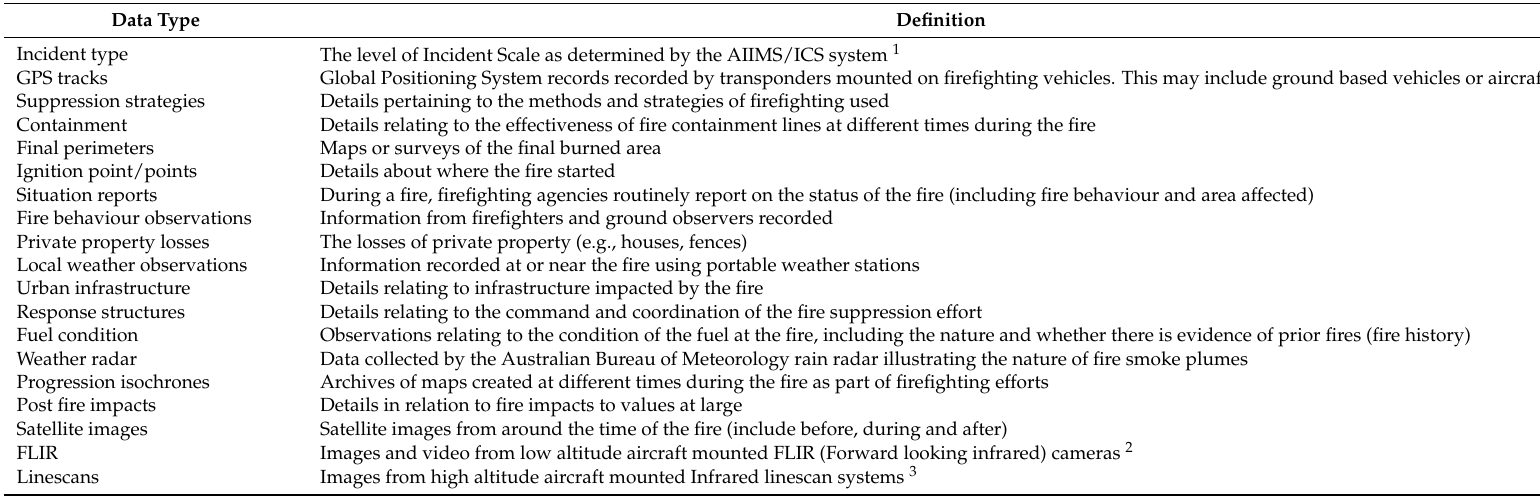
Table 2. Categories and definitions used in fire data collection